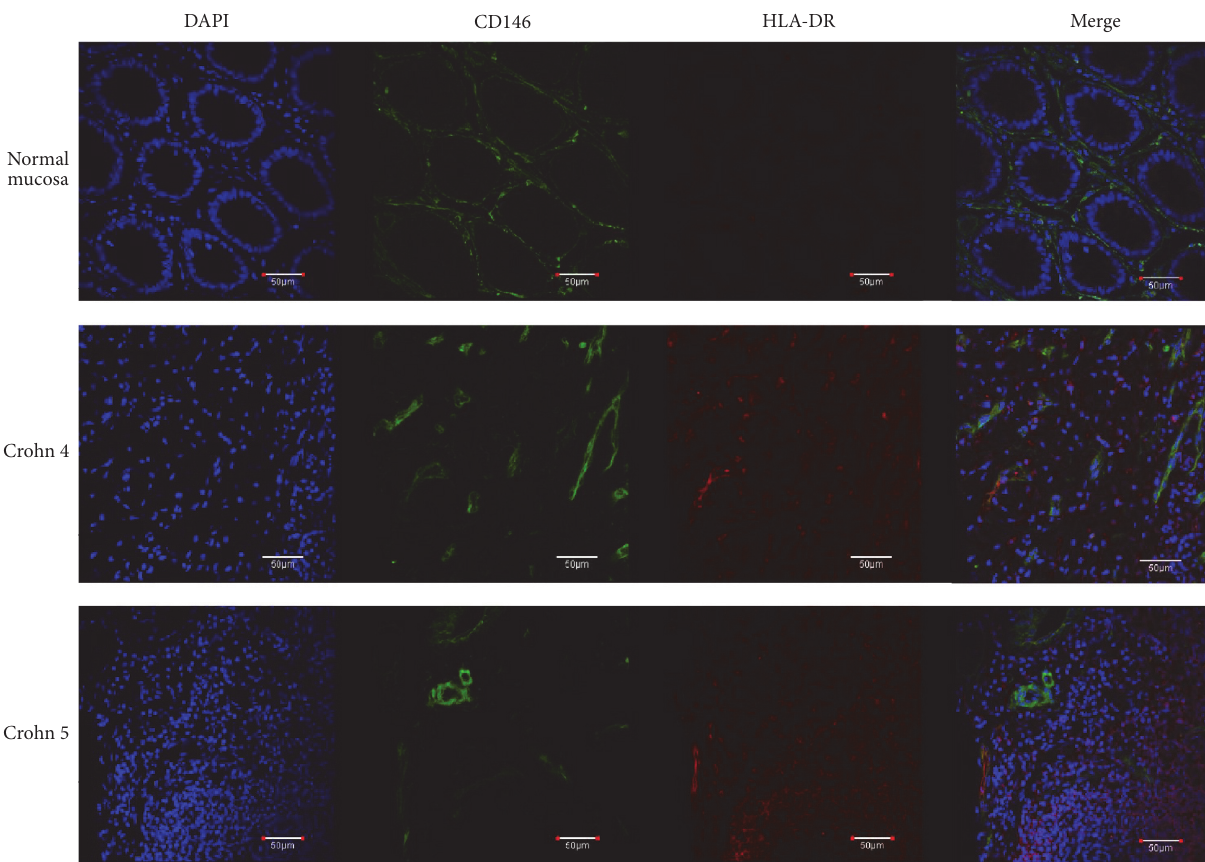
Figure 2: Immunofluorescence analysis of Crohn’s disease surgical specimens. In contrast to the typical structure of normal distal intestine mucosa, Crohn’s disease sections have a totally subverted architecture wherein the presence of some CD146+ cells expressing high levels of HLA-DR (white arrows) is detected, in close proximity to or interspersed between smaller HLA-DR+ cells. Normal colonic mucosa and Crohn’s disease specimens were obtained from patients who signed an informed consent before undergoing surgical resection. Tissues were fixed in PFA 4% o/n at +4 ∘ C, embedded, frozen in OCT, and stored at − 80 ∘ C. Thick sections (15 𝜇 m) were cut on a cryotome and processed for immunofluorescence staining. Permeabilization was performed with 0.5% Triton X-100 in PBS for 30 󸀠 , at room temperature. A blocking step was performed using 40 𝜇 g/mL mouse IgG in 3% BSA (PBS) for 2h at RT, and subsequent incubation with primary antibodies was carried out for 16h at +4 ∘ C. Primary antibodies used were FITC conjugated mouse anti-CD146 (Biocytex) and R phycoerythrin-labeled mouse anti-human HLA-DR (Becton-Dickinson). The final step, before mounting the slides, was incubation with a TRITC-conjugated goat anti-PE secondary antibody (Aviva Systems Biology), for 2 h at 37 ∘ C. Nuclear staining was executed adding RNAse and DAPI to the secondary antibody incubation mix. Images were acquired with an Olympus FV-1000 spectral confocal microscope, equipped with an UPLFLN 40x 1.30 NA oil immersion objective. Scale bars correspond to 50 𝜇